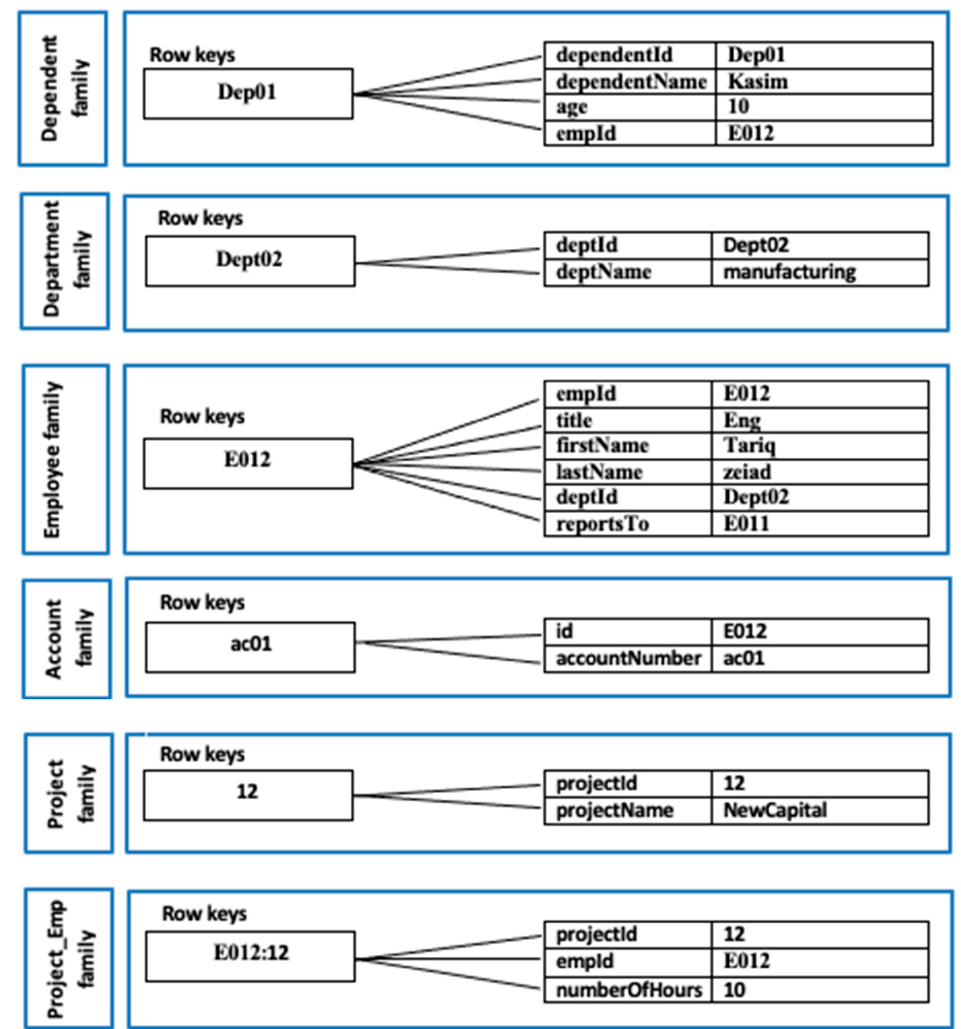
Figure 4. Column schema generated by applying rules 12, 16, and 17 to Figure 2. Algorithm 3: Transformation and Migration from RDB to Key–Value